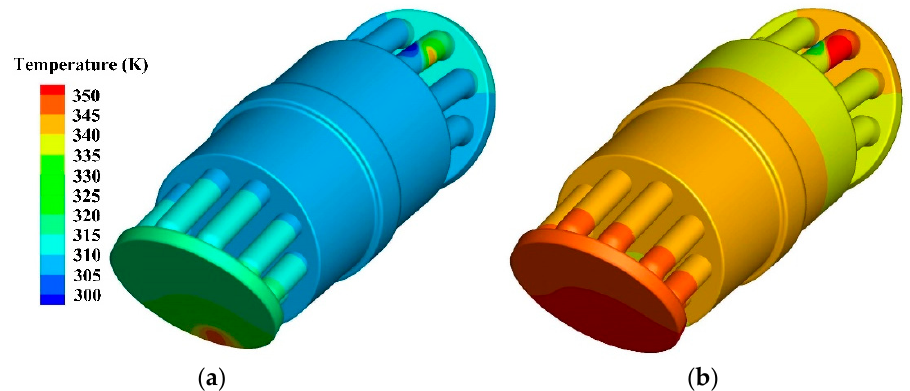
Figure 7. The temperature distribution of machinery elements inside the axial piston pump at ( a ) rotating speed of 3,000 r/min; ( b ) rotating speed of 3,600 r/min.